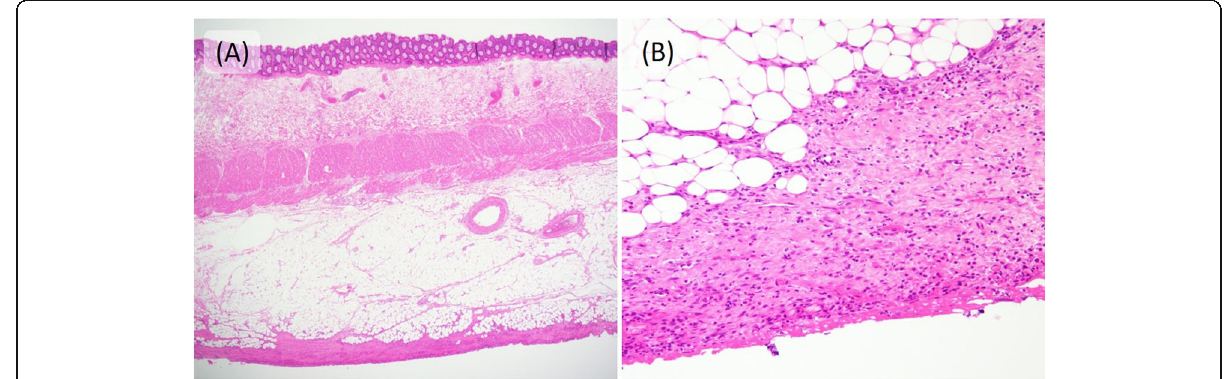
Fig. 5 Histopathological findings near the site of the perforated transverse colon. a Edematous change is mainly observed in the submucosal layer, but there was no necrosis. b Inflammatory cell infiltration, including neutrophil and deposition of fibrin, is observed on the serosal membrane (hematoxylin-eosin staining, a × 20 magnification. b × 200